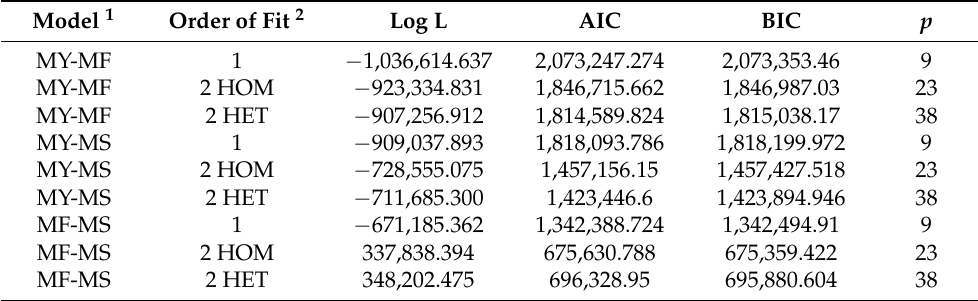
Table 4. Log-likelihood value (Log L), Akaike’s information criterion (AIC) and Bayesian infor- mation criterion (BIC), number of parameters (P), for different models in two-trait trait random regression analysis.